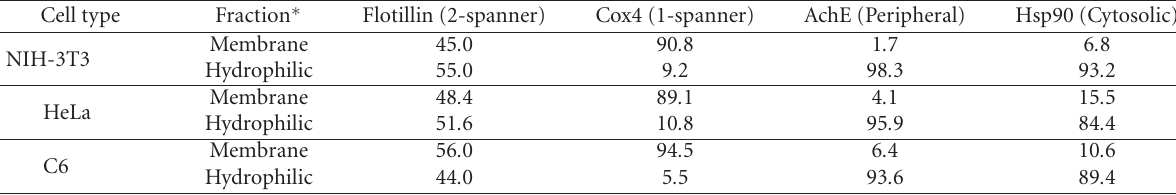
Table 1. Quantification of mammalian cell lysate proteins fractionated with the Mem-PER reagents in Figure 2. Cell type